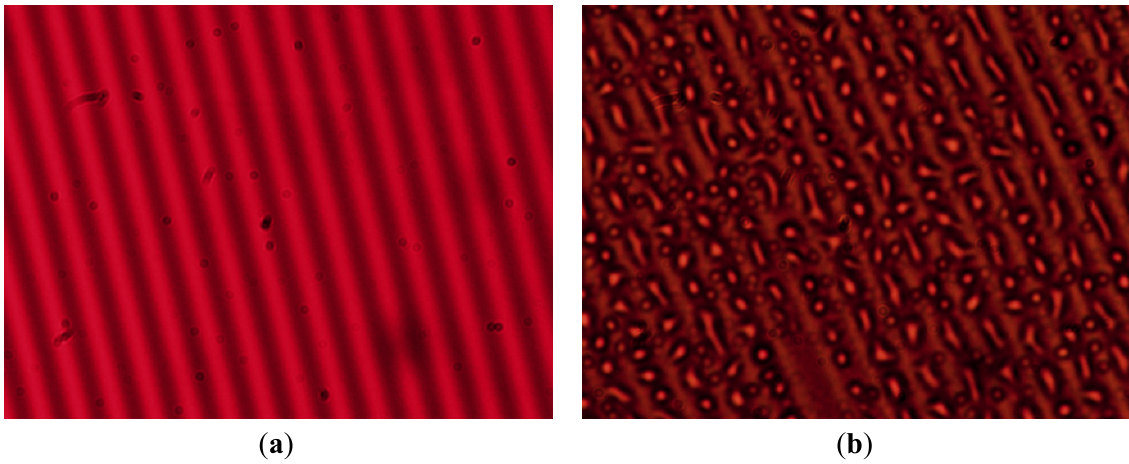
Figure 18. Photomicrograph of diffraction gratings with 454 lines/mm, sample C, ( a ) without voltage, ( b ) with